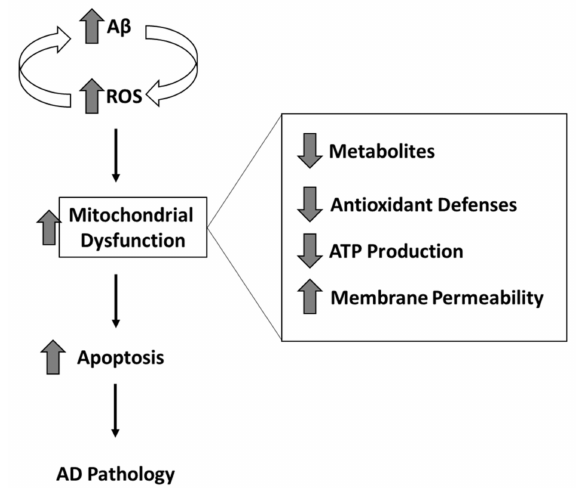
Figure 4. Mitochondrial dysfunction related to oxidative and / or nitrosative stress that is in turn associated with amyloid β -peptide oligomer inserted in the mitochondrial membranes. Consequences of these oxidative or nitrosative stress-mediated dysfunction include, among others, decreased levels of ATP production, decreased levels of metabolites, decreased levels of antioxidant defense, and an increased mitochondrial permeability transition pore (MPTP) transport of cytochrome c, all of which are highly detrimental to both mitochondria and consequently neurons. See text for more